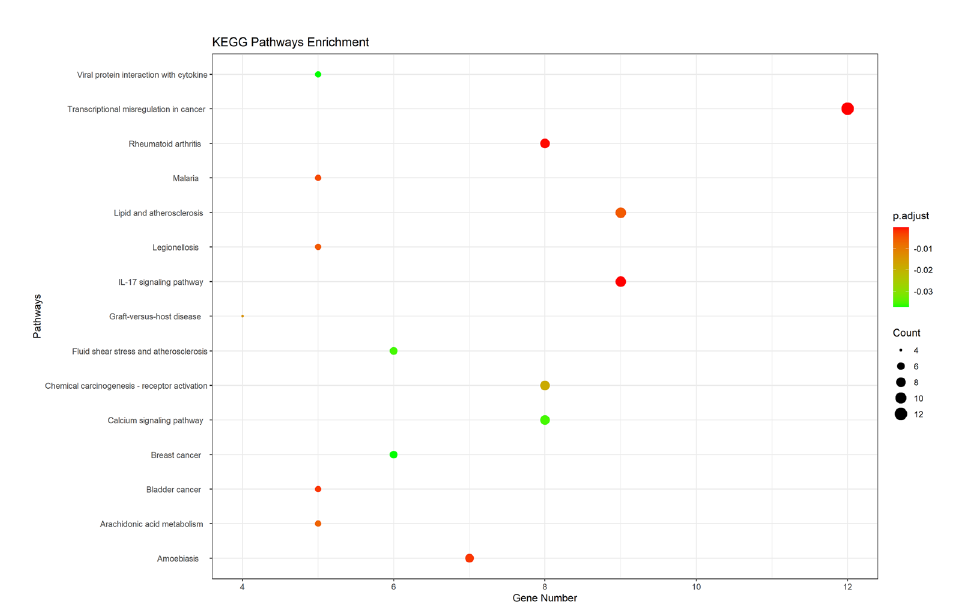
Figure 5. KEGG pathway enrichment analysis of the anti-Peri-implants targets of